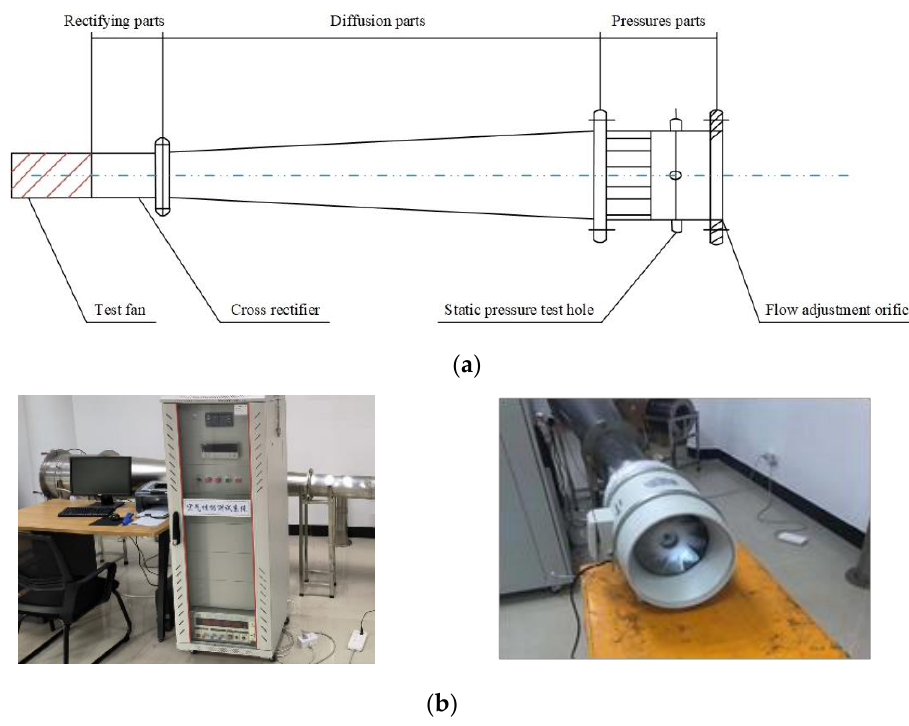
Figure 5. Air performance test. ( a ) Test device diagram ( b ) Field test diagram.